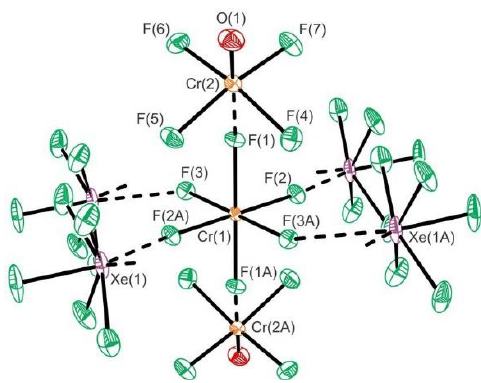
Figure 10. The coordination sphere of the [CrF 6 ] 2 − in the crystal structure of [XeF 5 ] 2 [Cr IV F 6 ] · 2Cr VI OF 4 . Secondary Xe ··· -F and Cr ··· F bonding interactions are indicated by dashed lines. Copyright (2019) Wiley. Used with permission from Ref. [38].